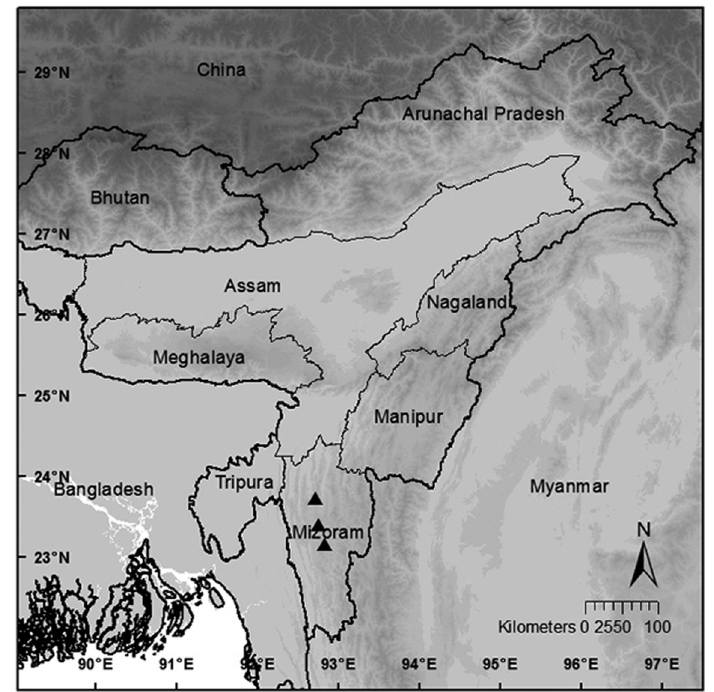
Fig. 38. Map showing the location of B. lushaiensis C.E.C.Fisch.